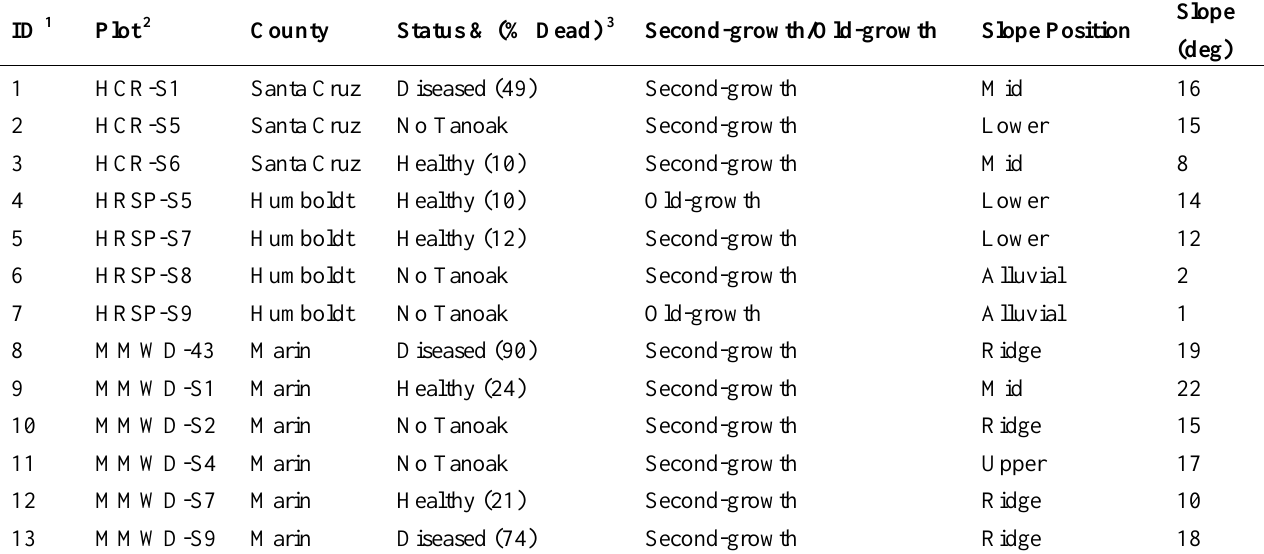
Table 1. Key characteristics of sample